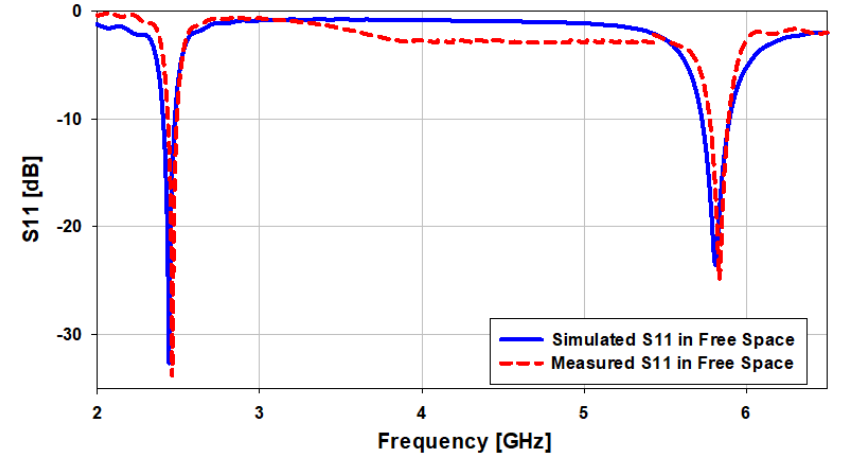
Figure 10. Comparison of the simulated and measured S 11 in free space.